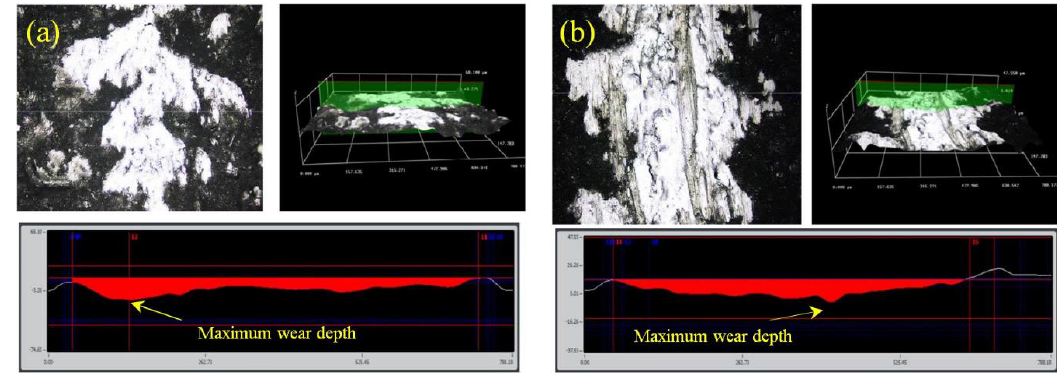
Figure 1. Scanning electron microscope (SEM) and 3D-profilometer image of the wear tracks: ( a ) produced by D-gun technique; ( b ) produced by the supersonic plasma spraying (SSPS) technique.